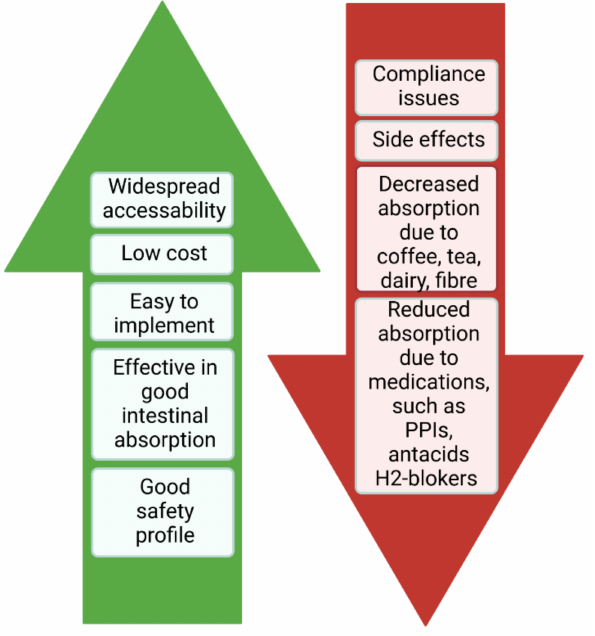
Figure 2. The advantages and drawbacks of oral